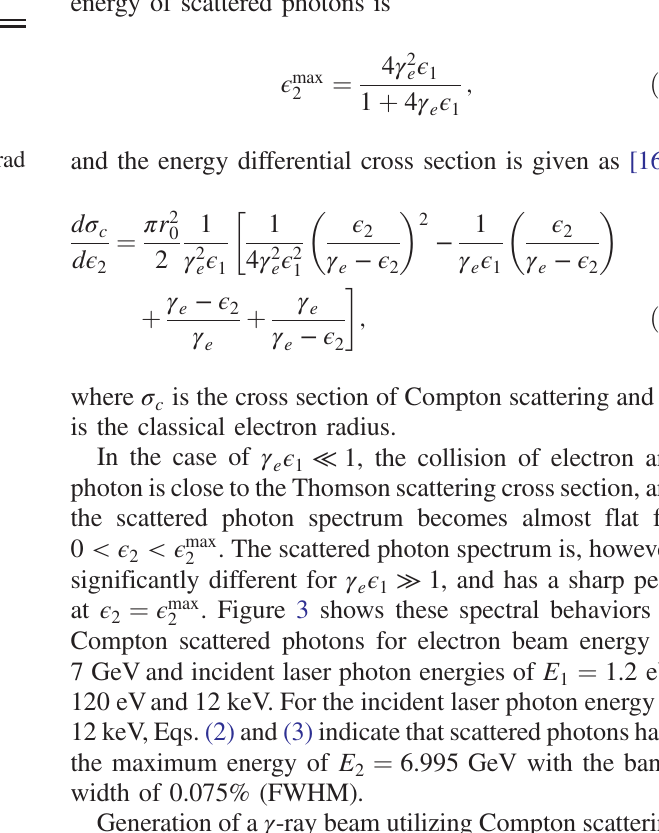
TABLE I. Parameters of the XFELO for the baseline design of XFELO- γ .